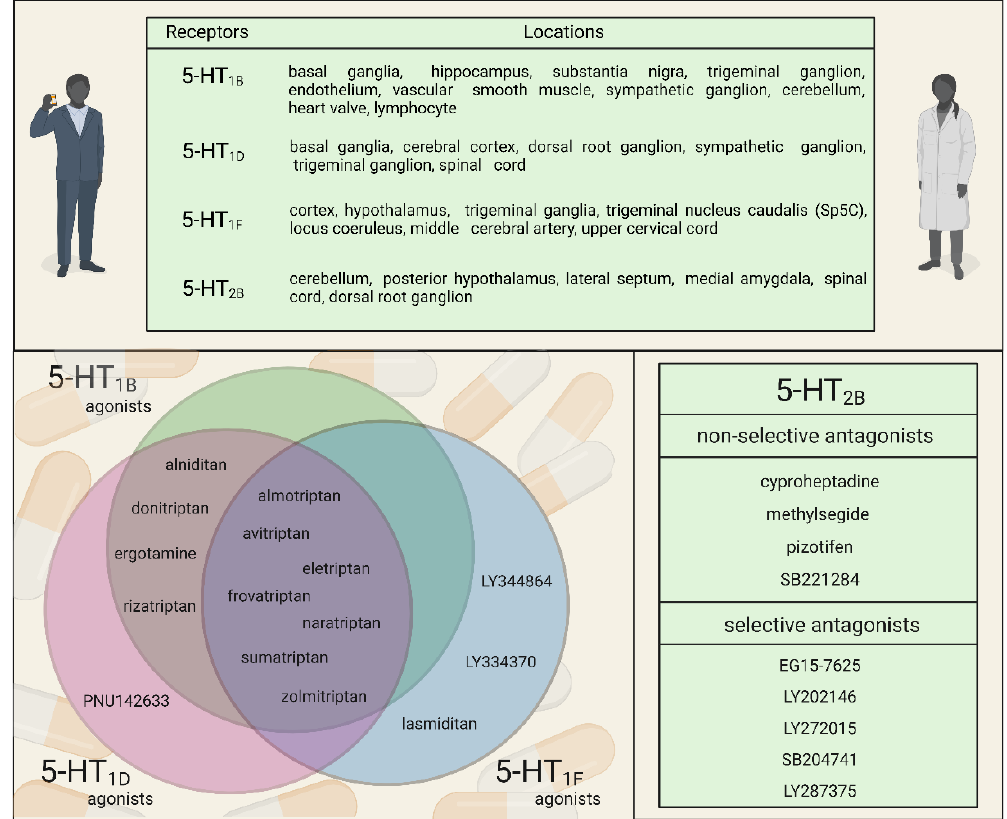
Figure 3. 5-HT receptors and their relevance in migraine therapy.